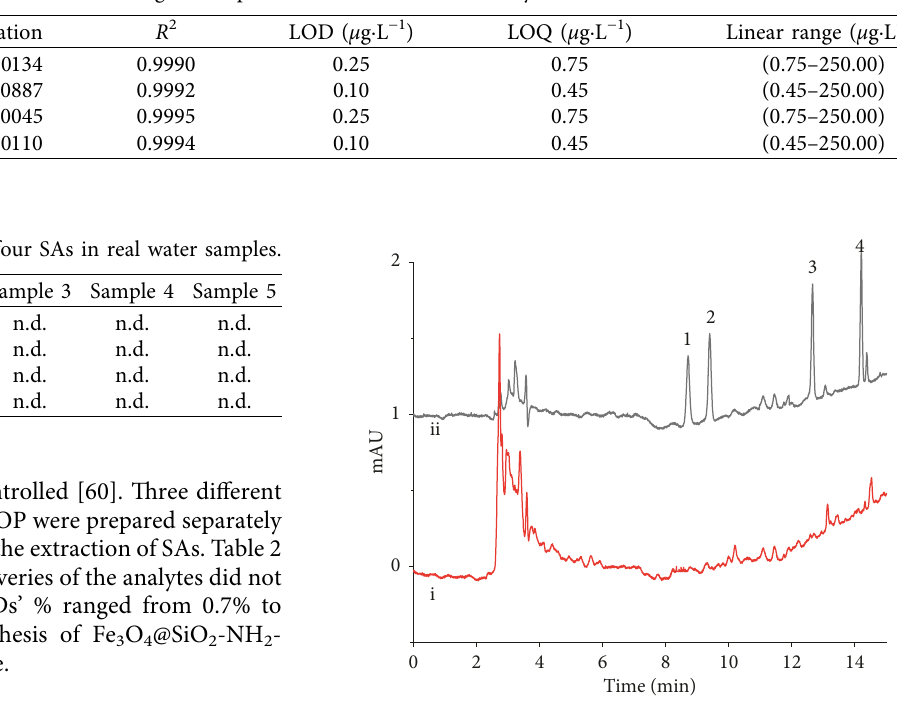
Table 3: Regression parameters of the four SA analytes.